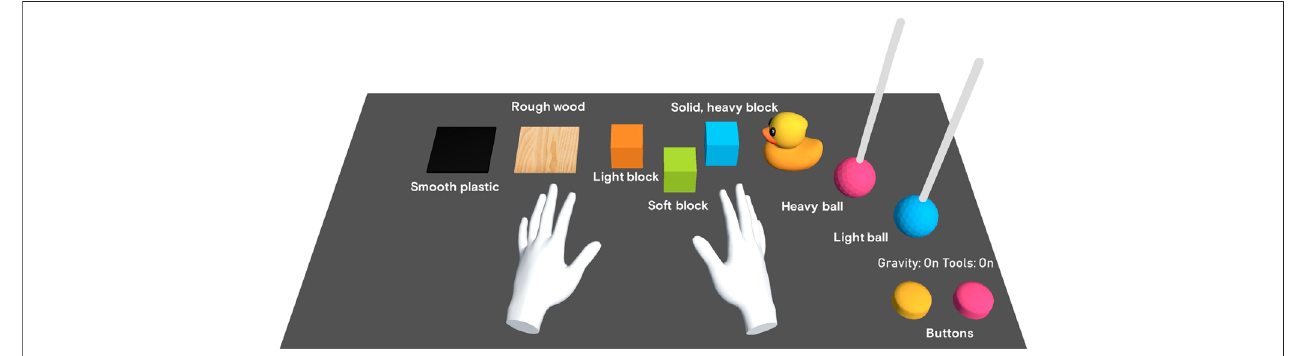
FIGURE11| Aftertheuserstudyconcludes,participantsarepresentedwithadeskwithvariousobjectstointeractwith.Fromlefttoright:asmoothplasticsquare, a rough wooden square, a lightweight orange block, a soft green block, a heavy blue block, a rubber ducky (solid), a heavy tethered ball, a lightweight tethered ball.